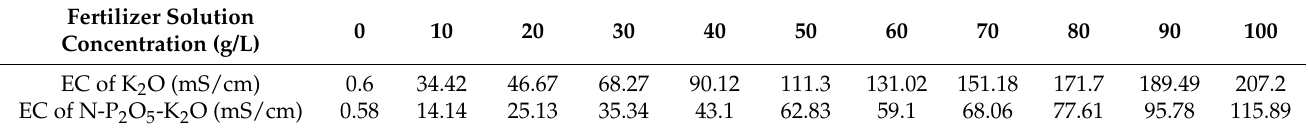
Table 2. Test data sheet of the relationship between the concentration of fertilizer and the conductivity.